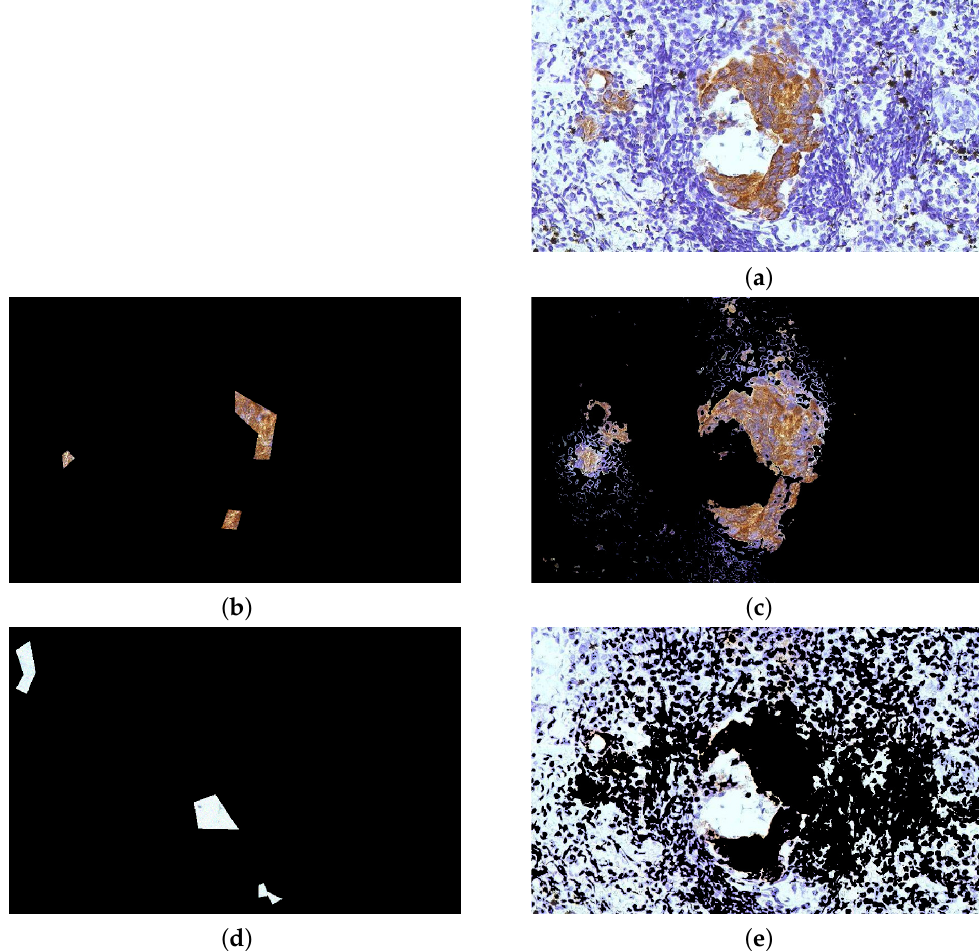
Figure 13. Matlab’s tissue image. ( a ) original image. ( b ) marked brown region, ( c ) segmentation results of the label. ( d ) marked background region, which includes both white background and blue cells. ( e ) segmentation of the background. The results are obtained with α = 1.2, β = 1.